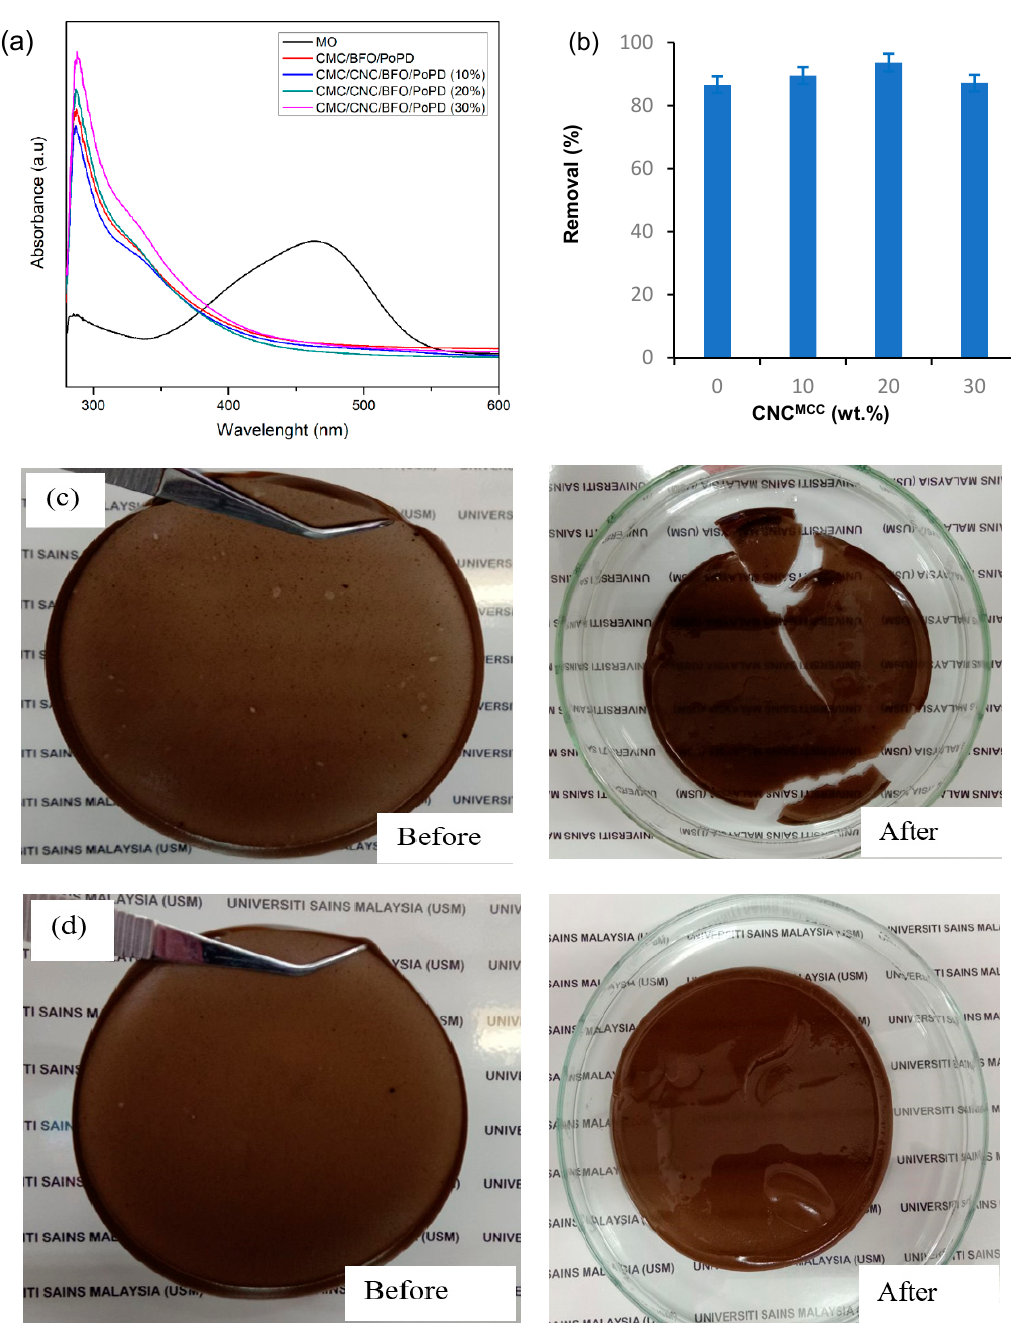
Figure 4. ( a ) UV-visible absorbance and ( b ) percentage removal of methyl orange of different percentages of CNC MCC added to CMC/BFO/PoPD film. The photographic images of the nanocomposite films ( c ) CMC/BFO/PoPD and ( d ) CMC/CNC MCC/ BFO/PoPD before and after 3 h of photocatalytic activity for the removal of methyl orange dye.